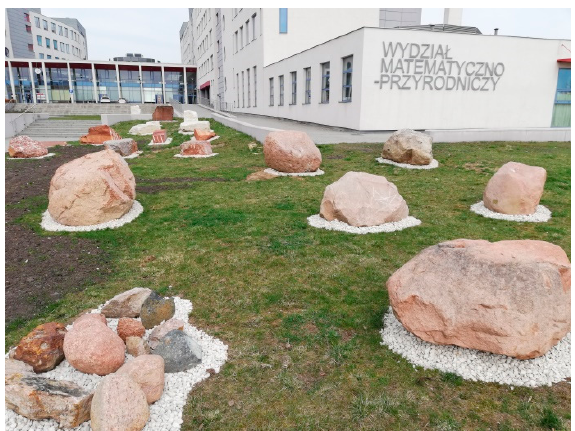
Figure 2. Rock Garden of the Institute of Geography and Environmental Sciences at Jan Kochanowski University in Kielce—general view.